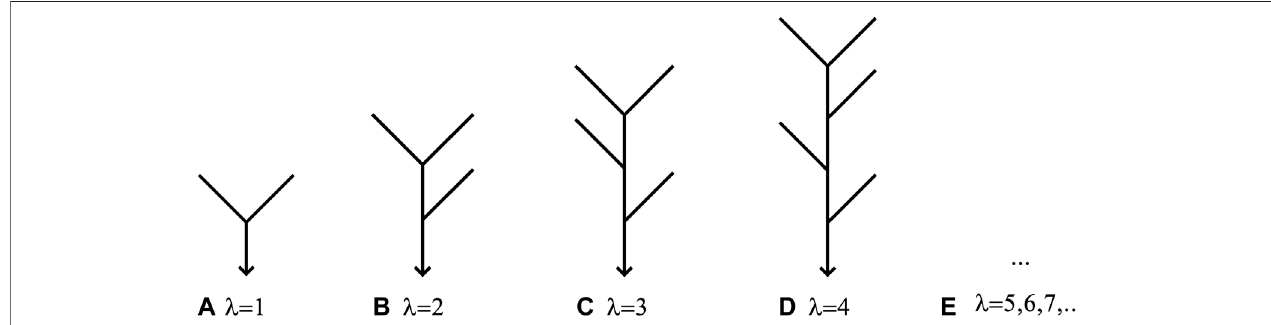
FIGURE3 | Diagrammaticin fi nite generator series forthe topological structure ofiterative binary treenetworks. Here, λ isthe index ofeach generator [revised from Zhang et al. (2009)].